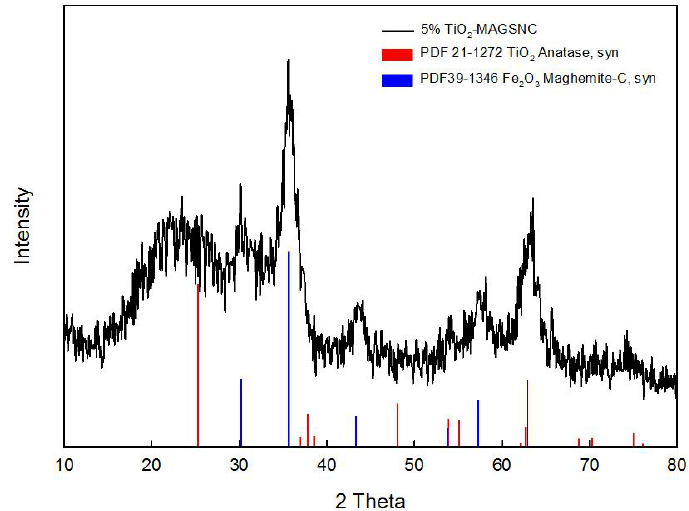
Figure 2. X-ray diffraction (XRD) pattern of 5% TiO 2 -magnetically-separable photocatalysts (MAGSNC) photocatalysts. (PDF 21-1272 and PDF 39-1346 are the card numbers for the crystalline structures in the data base, while Anatase, syn and Maghemite-C, syn are the corresponding structure names.)